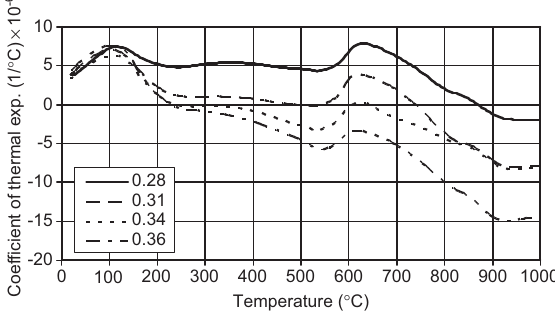
Figure 13 CTE of SCLC with diatomite vs. temperature.